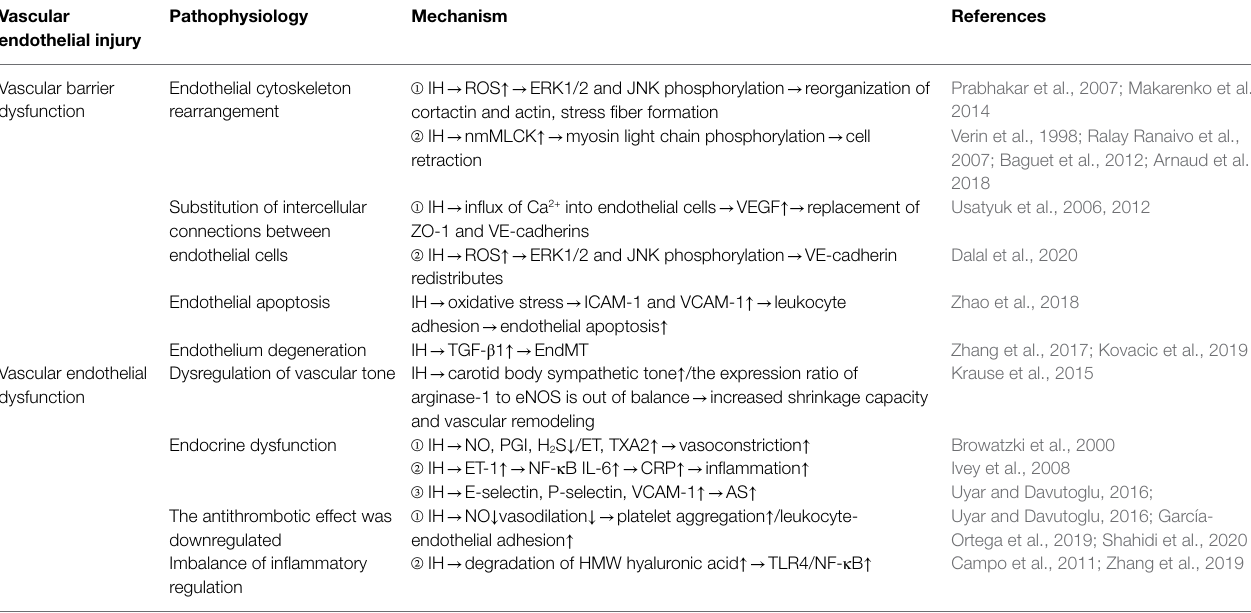
TABLE 1 | Mechanism of VE injury caused by chronic